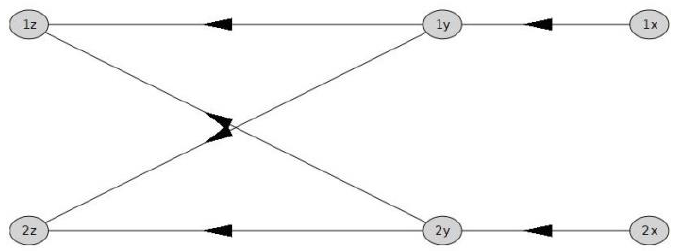
Figure 11. Graphical representation of the first attempt to codify a scissors crossing. The connectivity of the scissors crossing is correctly represented in the digraph; however, there is no way to detect whether the two routes intersect or not at the crossing. Second attempt: a new vertex, denoted, for instance, 0yz , is included at the center of the scissors crossing (Figure 12); and the directed arcs (1y,2z) and (2y,1z) are substituted by (1y,0yz) , (0yz,2z) , (2y,0yz) , and (0yz,1z) . This way, it is straightforward to detect whether the two routes intersect or not at the crossing (just checking whether vertex 0yz belongs to both routes or not). Unfortunately, the connectivity of the digraph would not be correct, allowing, for instance, the route 1y → 0yz → 1z if there was a problem in the directed arc (1y,1z) ; as if the crossing was a double-slip turnout (which, by the way, would be absurd here to install and impossible to install—due to the short length of the